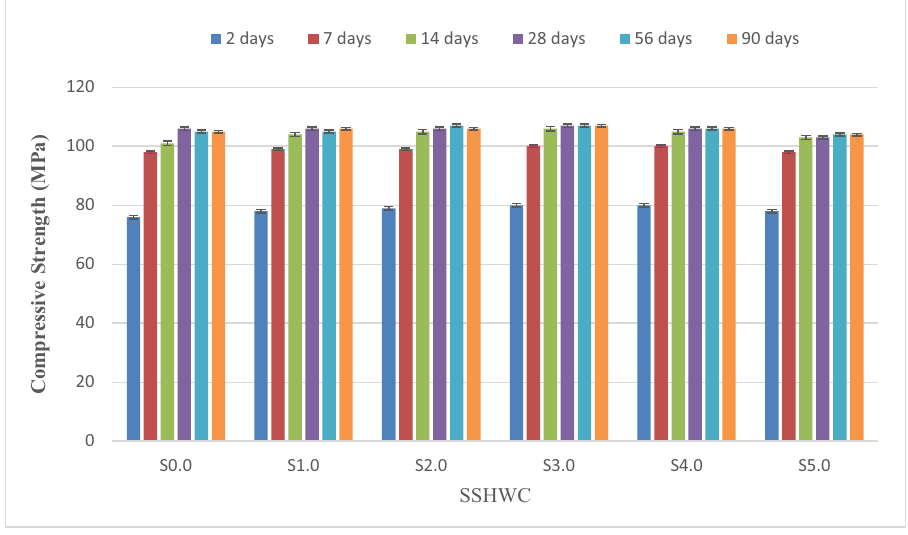
Figure 8: The SSHWC